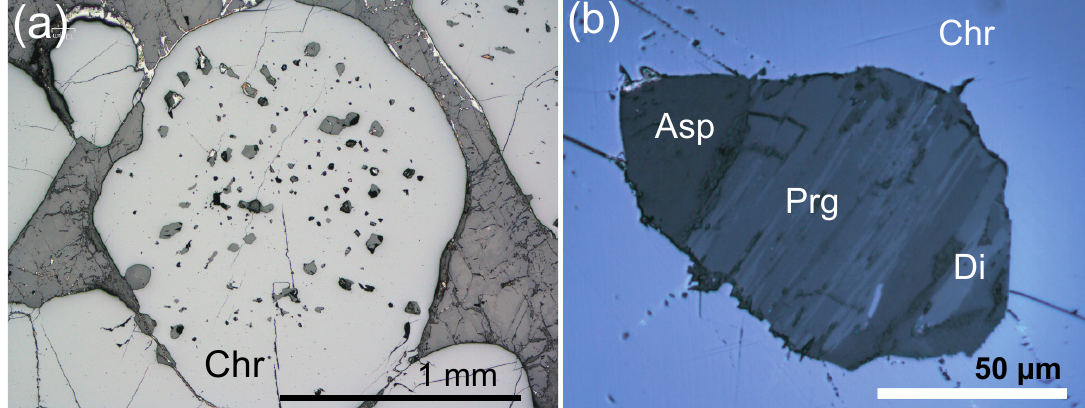
Figure 2. Polymineralic silicate inclusions in a discordant podiform chromitite chromite in wadi Hilti, the northern Oman ophiolite. See Miura et al. [16] for detailed petrological descriptions of this chromitite pod. Chr, chromite; Asp, aspidolite; Prg, pargasite; Di, diopsidic clinopyroxene. ( a ) Photomicrograph of the Hilti chromitite by reflected light. Note the central chromite grain, where inclusions are distributed evenly or concentrically. ( b ) Back-scattered electron image of an inclusion. Note their hydrous and Na-rich character.